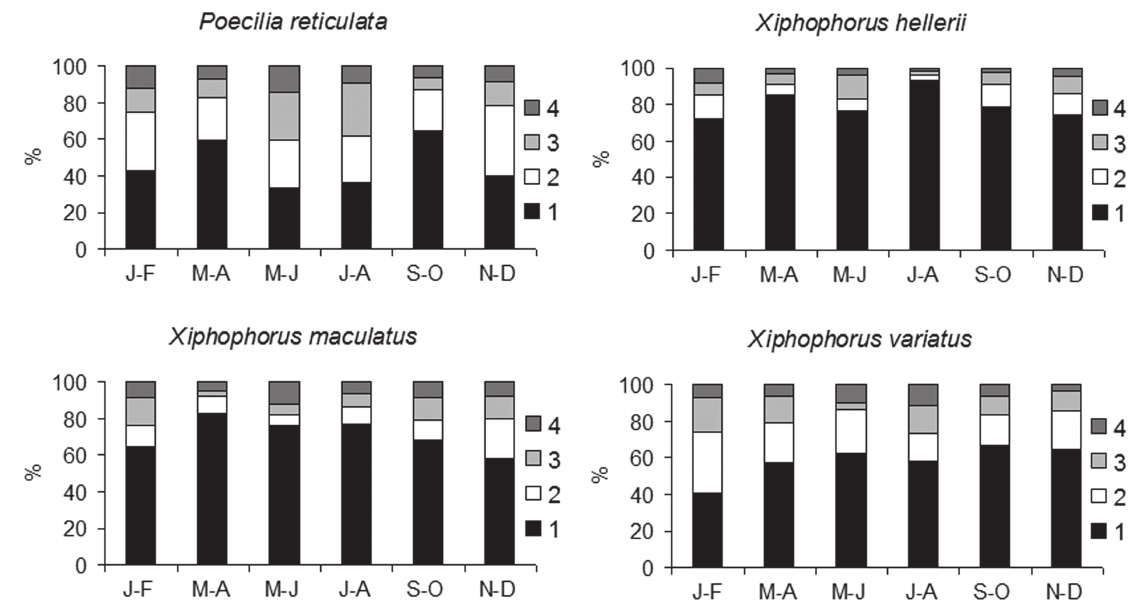
Fig. 6. Relative bimonthly frequency of developmental stages in ornamental non-native poeciliid females collected in Gavião Creek, 2006. Developmental stages: 1 Non-gravid, 2 Yolked ova, 3 Eyed embryos, 4 Mature